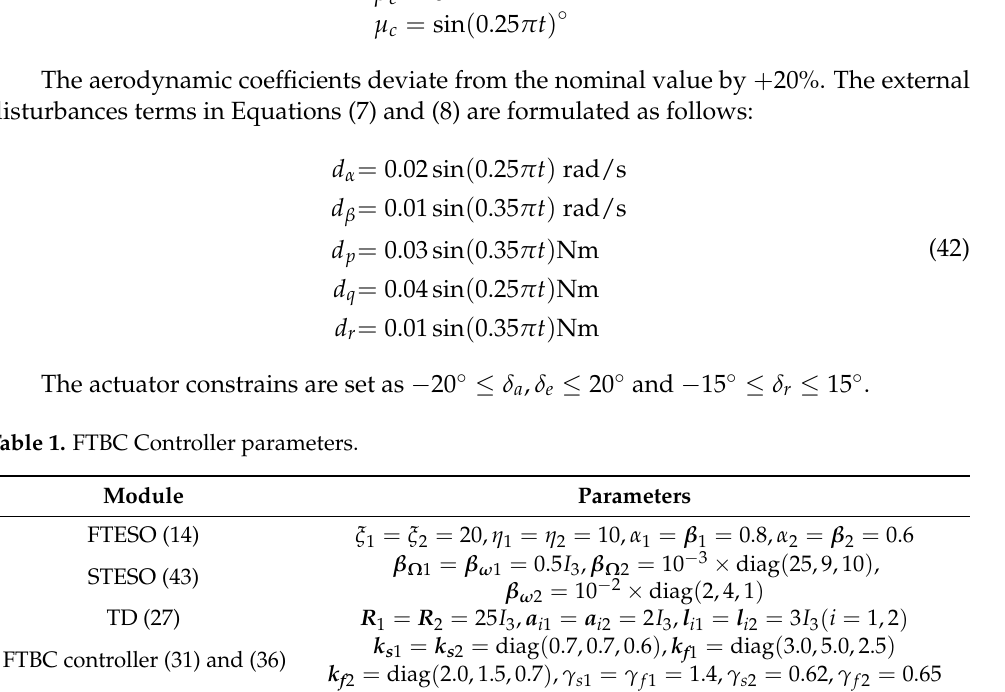
Table 1. The reference commands α c , β c , and µ c are set as: